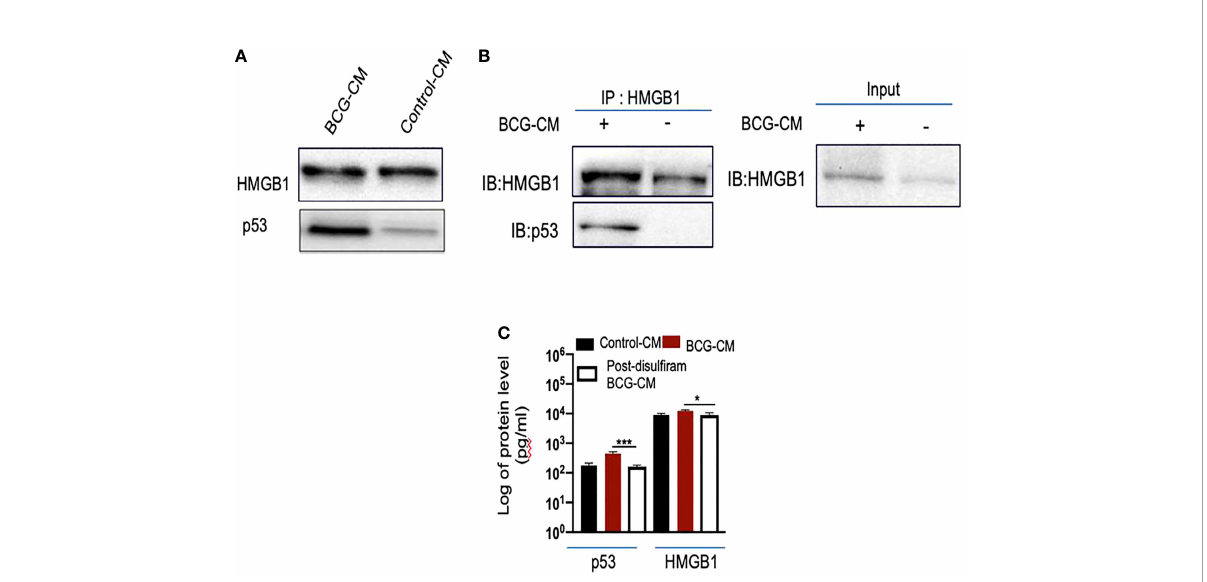
FIGURE 5 BCG-infected EpCAM+/ABCG2+ CSCs release HMGB1/p53 complex during pyroptosis. (A) Western blot of concentrated BCG-CM and control-CM showing the presence of HMGB1 and p53. 10 µg of protein was loaded in both infected and control group. (B) Immunoprecipitation experiment con fi rms the formation of HMGB1/p53 complex in BCG-CM versus control-CM. Immunoblotting (IB) of HMGB1 and p53 was also performed. Input is 2.5% of the total amount of immunoprecipitated. (C) The histogram is showing the secretion of HMGB1/p53 complex by BCG-infected EpCAM +/ABCG2+ CSCs with or without disul fi ram treatment (50 nM/twice daily for 4 days). The elute of IP/HMGB1 shown in (B) was subjected to ELISA, and protein levels were compared with uninfected EpCAM+/ABCG2+ CSCs (p53: average, 0.13 ng/ml; HMGB1: average, 10.5 ng/ml) to obtain fold change. Data represent means ± SEM. N = 3 independent experiments (A – C) . *p < 0.05 and ***p < 0.001 (Student ’ s